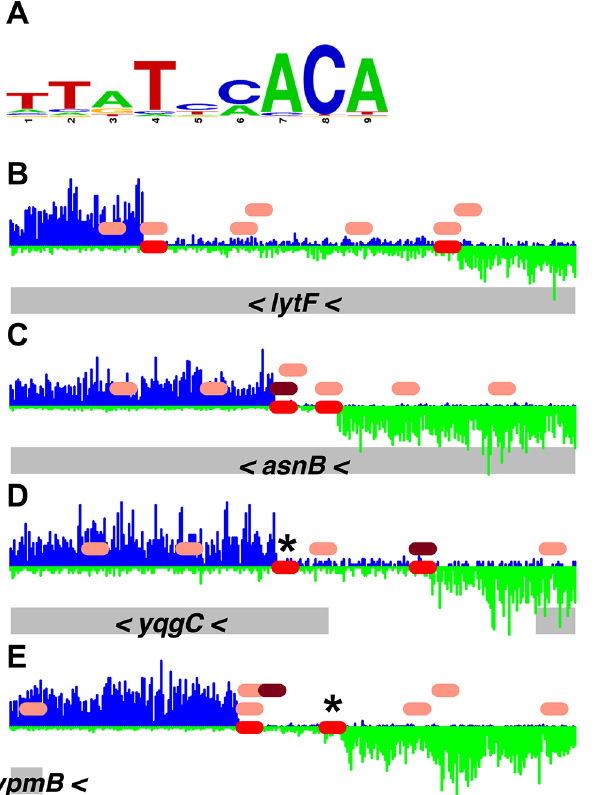
Fig 4. Comparison of DnaA boxes from a consensus sequence with DnaA boxes from the PSSM. (A) A logo, drawn using WebLogo [32], of the DnaA boxes used to construct the DnaA box PSSM is shown. (B-E) Histograms of the number of sequence reads that start at each nucleotide are plotted (blue for sequence reads mapping to the top strand; green for sequence reads mapping to the bottom strand). Data are from the binding reaction containing 4.1 μ M ATP-DnaA-his. For each panel, a 300 bp portion of the genome is presented, and the y-axes are scaled so that the data fills the space. The red ovals on the horizontal axis indicate the position of DnaA binding sites predicted using the PSSM described here. The pink ovals above the horizontal axis indicate DnaA boxes with 2 mismatches from the TTATNCACA consensus sequence, and the maroon ovals have 1 mismatch from the TTATNCACA consensus. (No perfect matches to the consensus are found in these regions.) The gray rectangles below the histograms indicate nearby genes, with arrowheads indicating the direction of